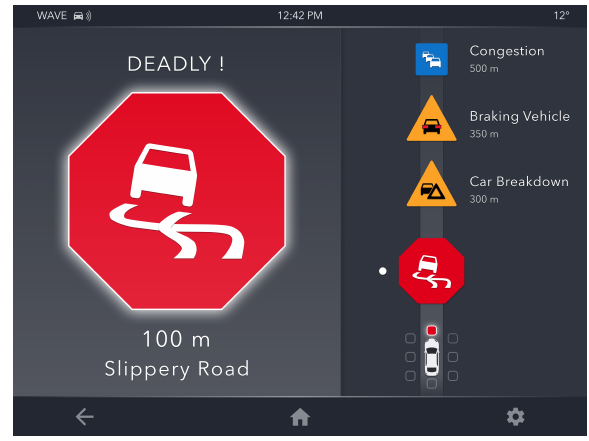
Figure 2. Three-stage warning